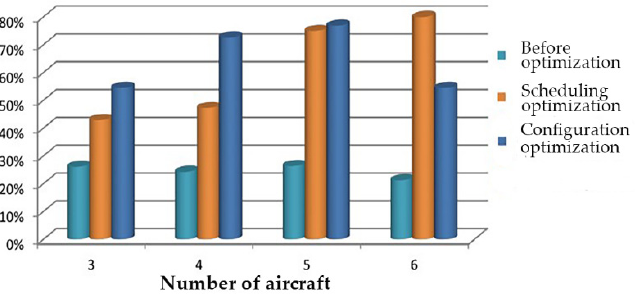
Figure 15. The relationship between the average utilization rate of power vans and the number of support aircraft.